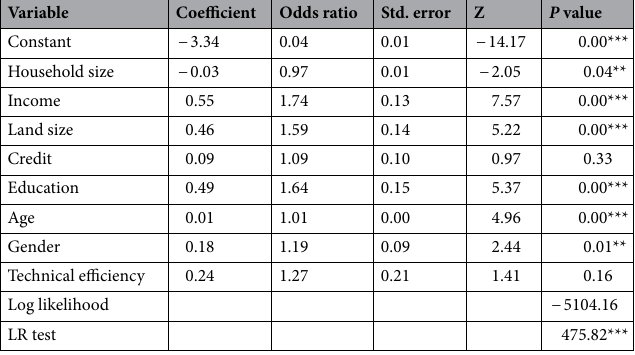
Table 5. Estimation for Logit regression. ***; **; * indicate significance at 1%, 5% and 10%